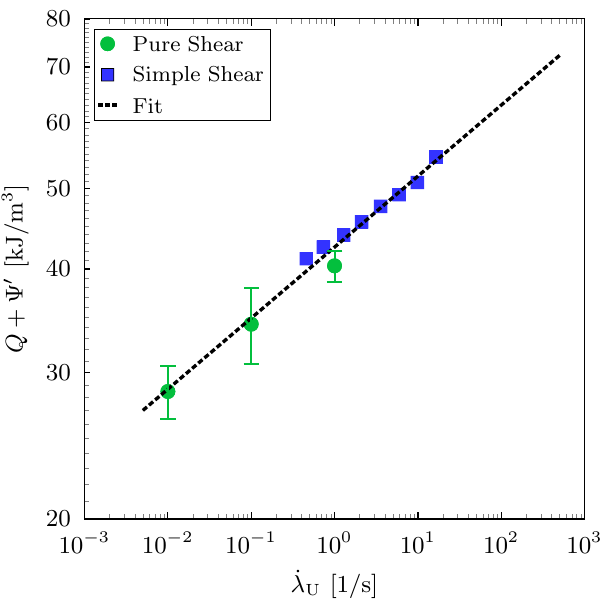
Figure 10. The relationship between the total dissipation and the unloading rate for pure shear and simple shear dynamic